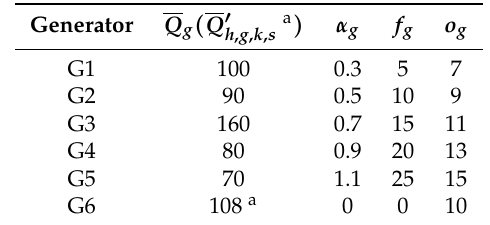
Table 1. Operational and maintenance information of the generators.